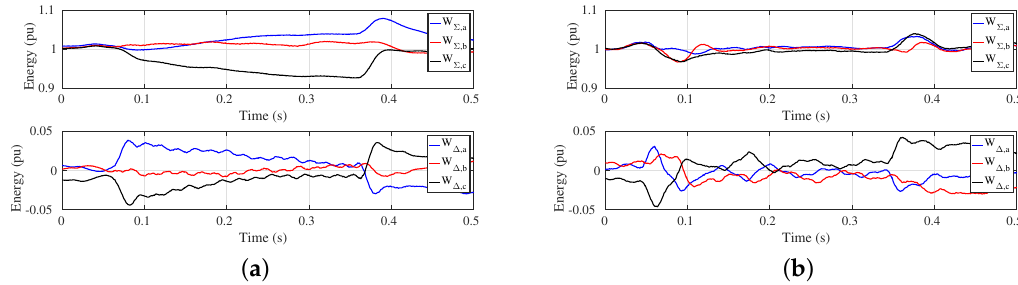
Figure 14. ( a ) W Σ and W ∆ for Scenario 1 without energy controllers and ( b ) with energy